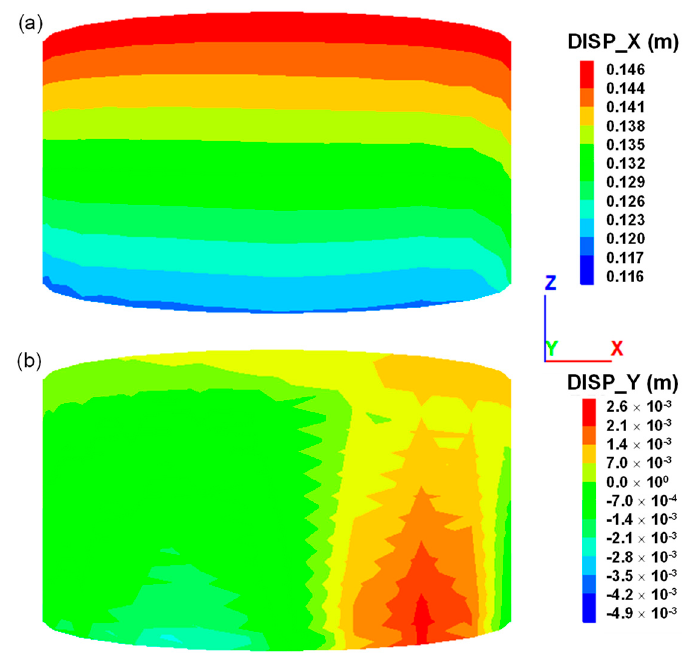
Figure 11. The residual horizontal displacement of bucket: ( a ) shaking direction; ( b ) the direction perpendicular to shaking.